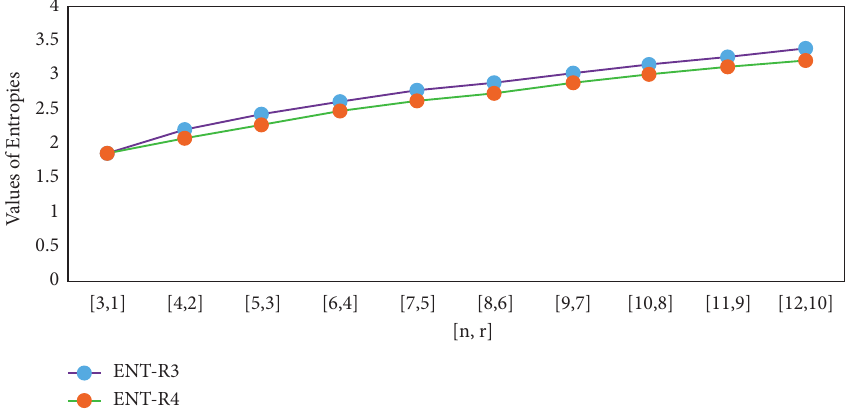
Figure 5: Comparison of Randic entropies for α � 1/2 and for α � − 1/2.